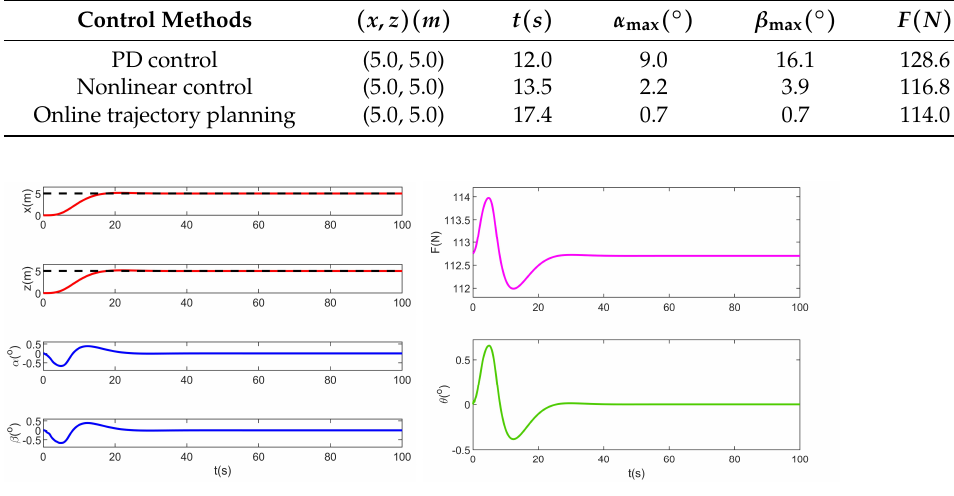
Figure 2. Simulations results for proposed method.